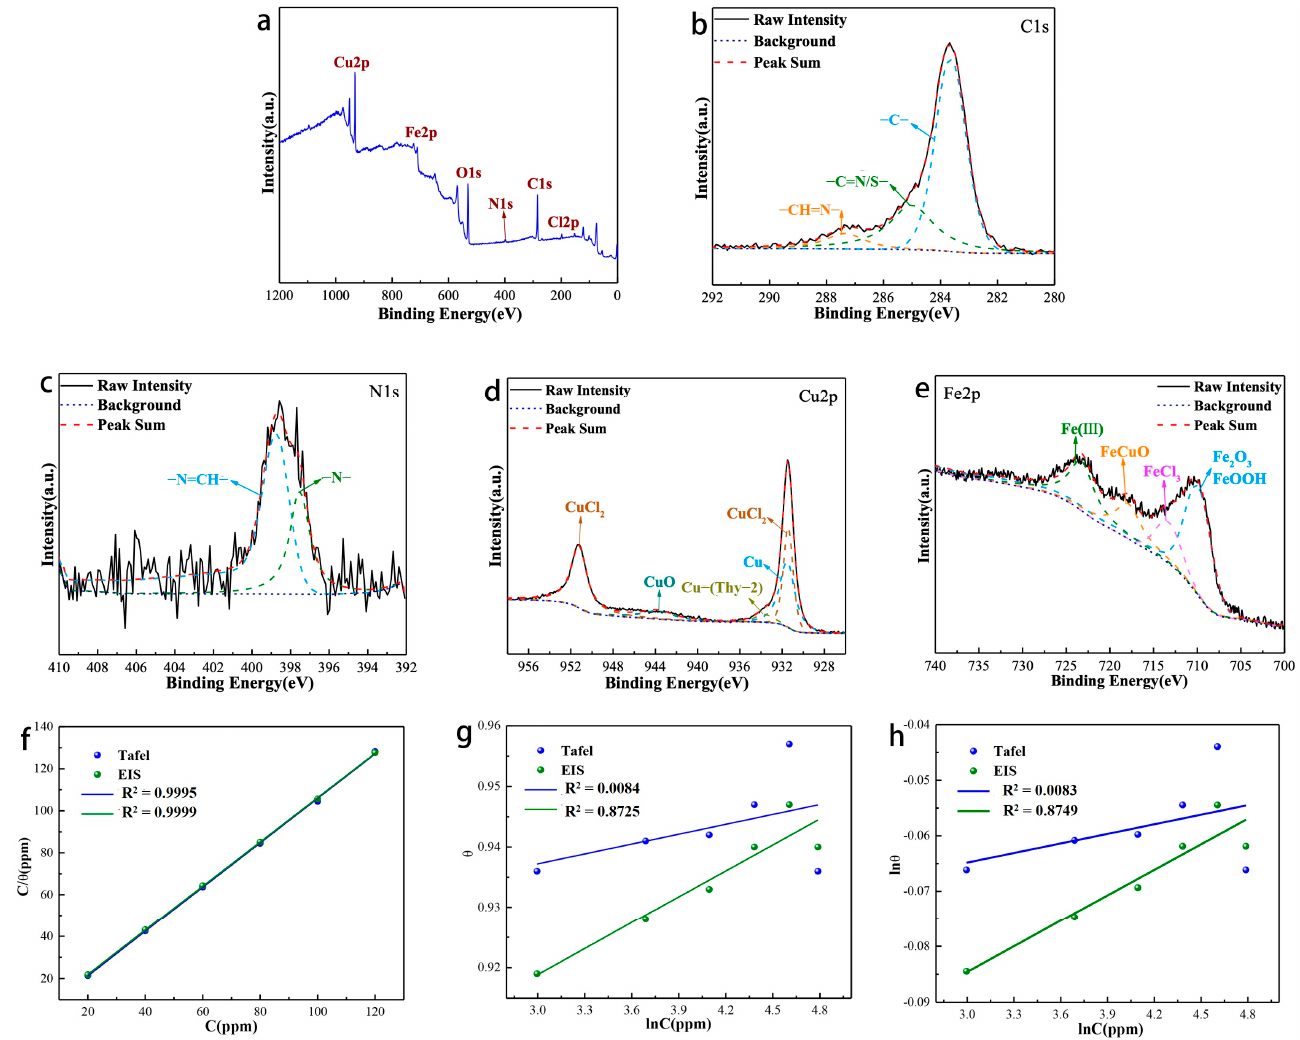
Table 5. Adsorption thermodynamic parameters of Q235 carbon steel in 1 M HCl calculated under di ff erent test conditions.